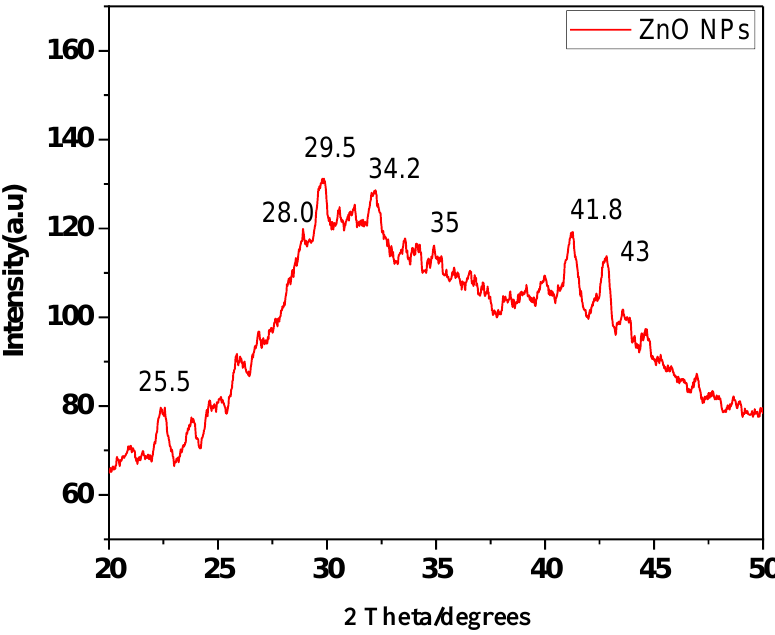
Figure 5. XRD analysis of ZnO NPs synthesized in A. indica . The crisp and powerful peaks clearly demonstrated the crystalline nature of ZnO